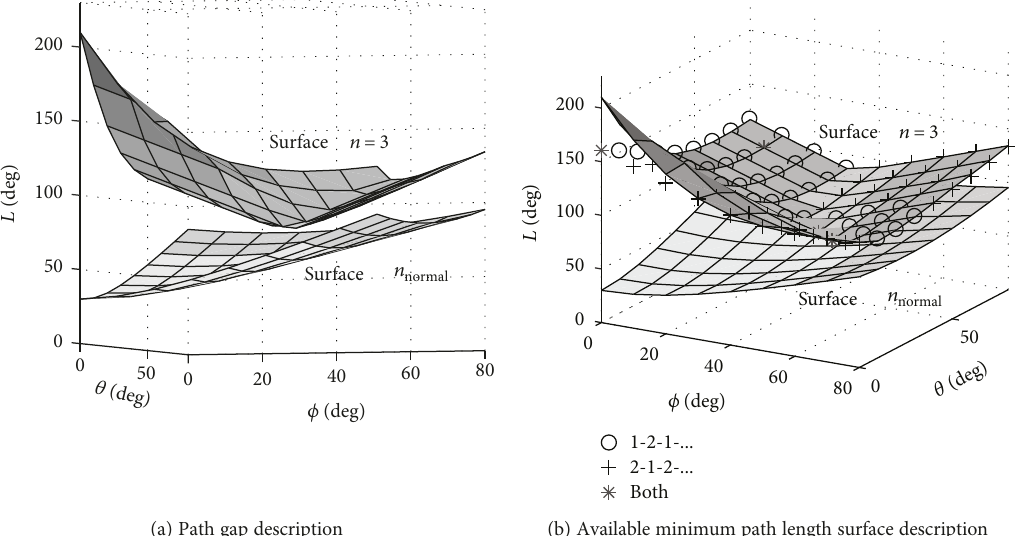
Figure 7: Path length results for arbitrary target attitudes ( ψ = 30 ∘